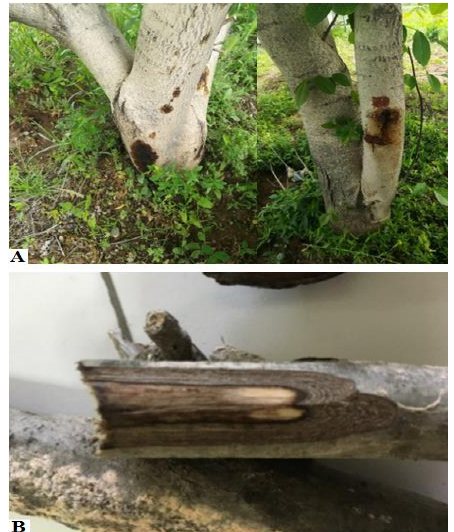
Fig. 1. The shallow bark canker and deep necrosis Symptoms: A) The symptom of shallow bark canker on the stem. B) The symptom of deep necrosis after removing branch bark.